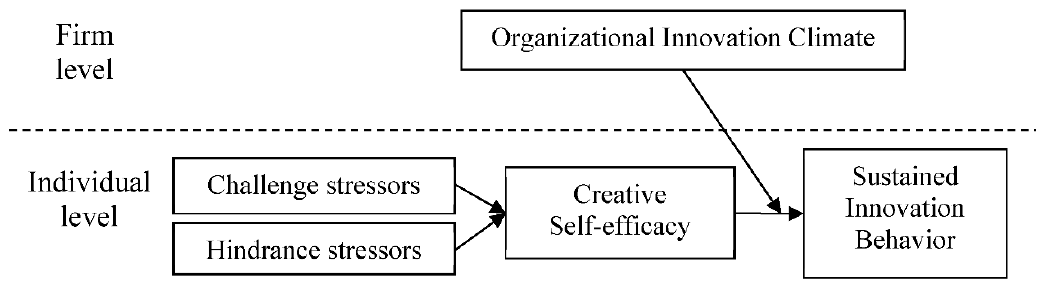
Figure 1. The framework of the effect of job stressors on the relationship between creative self-efficacy, the organizational innovation climate, and sustained innovation behavior.